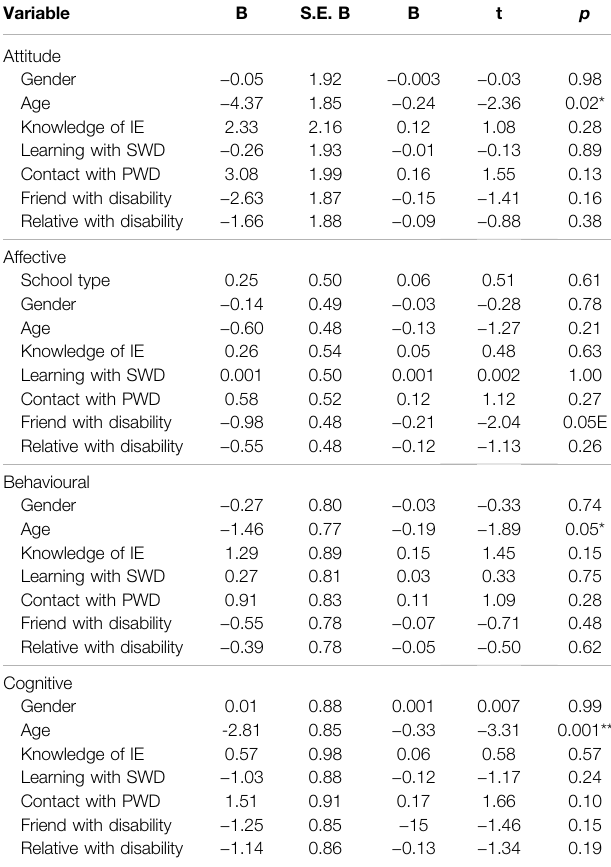
TABLE 4 | Predictors of attitudes towards peers with disabilities.